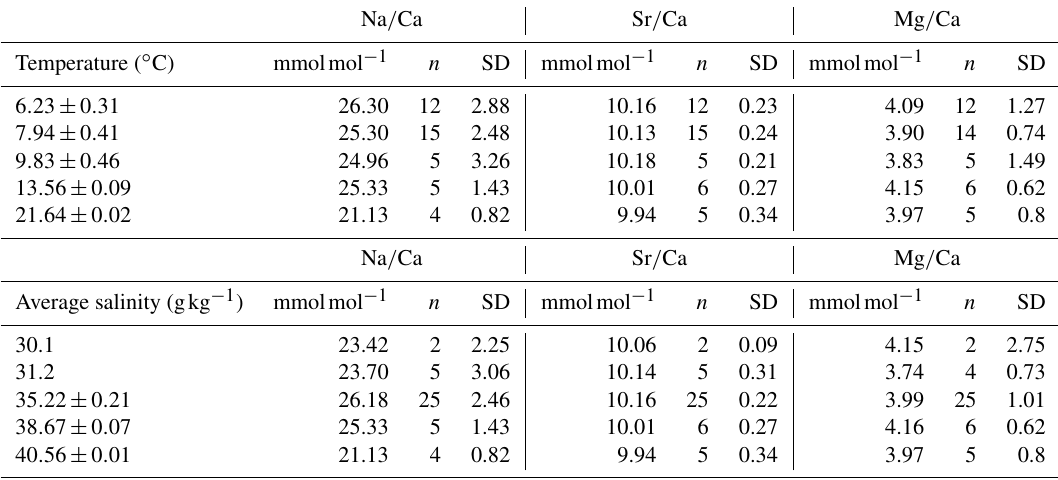
Table 1. Na / Ca, Sr / Ca and Mg / Ca mean values measured with ICP-OES; standard deviation and sample number. Values relate to certain salinity and temperature envelopes.